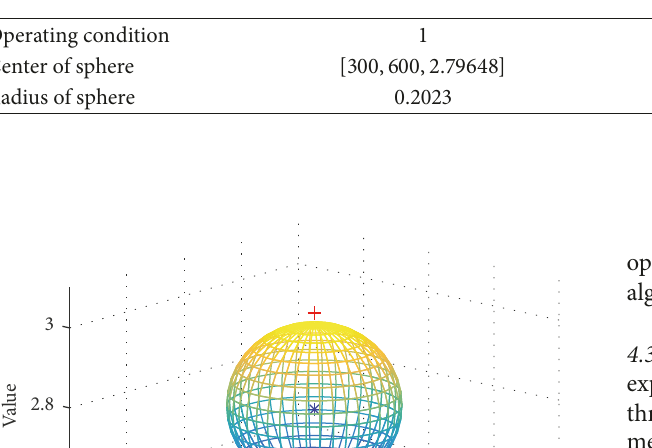
Table 7: Alarm threshold of the dual-rotor test rig.